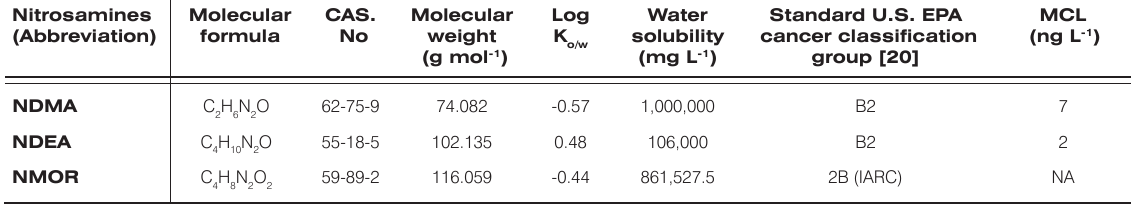
Table 1. Properties of the most commonly studied N-nitrosamines. Nitrosamines